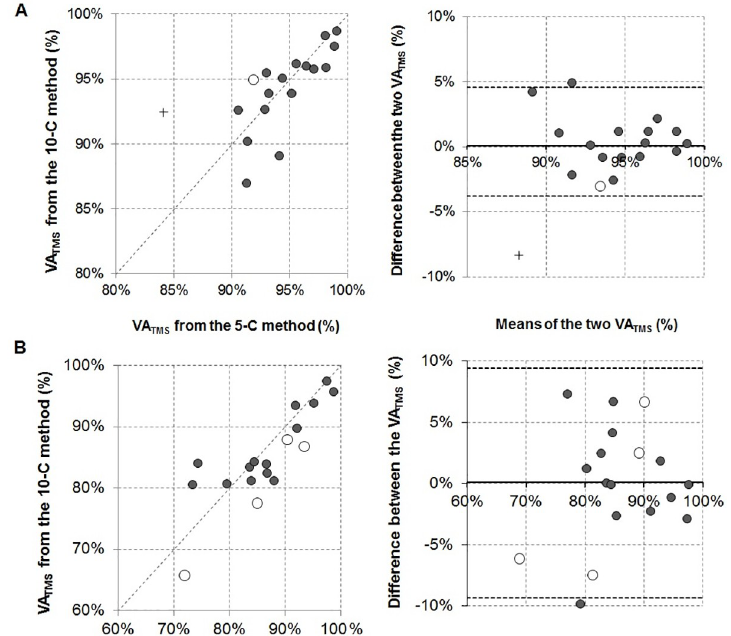
Fig 3. Scatter plots and Bland and Altman plots for the comparison of VA TMS using the 5-C method (Panel A, pre-exercise; Panel B, post-exercise). Panel A and B: White circles illustrate VA TMS values for which ERT had to be extrapolated from a 4-point relationship (for 1x5C only). Panel A: The cross shows an outlier that has to be removed to allow for the calculation of bias ± 95%